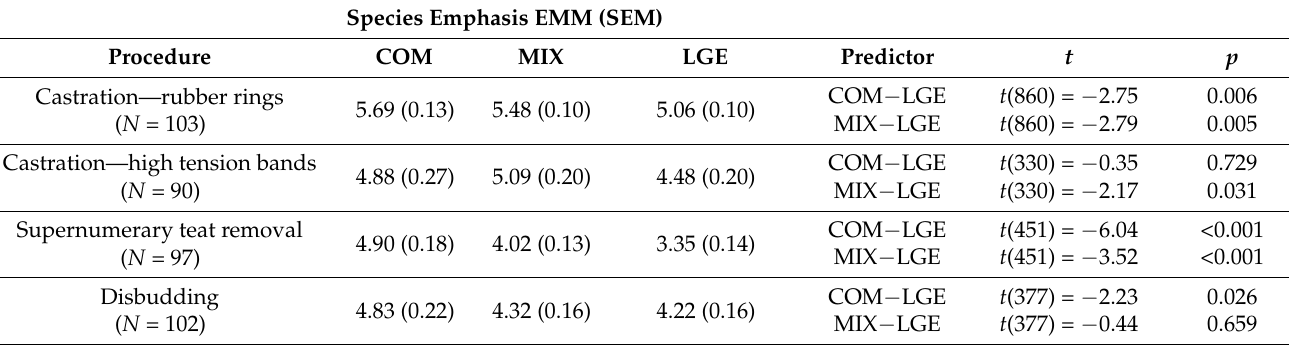
Table 6. Estimated marginal means (EMM) and standard errors of the mean (SEM) for the perceived pain scores a of veterinarians across certain husbandry procedures by species